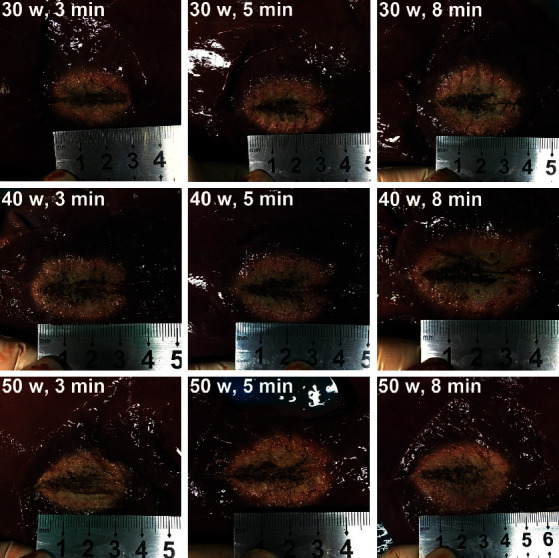
Ablation range of the microwave probe at varying power and time using a freshly excised porcine liver.